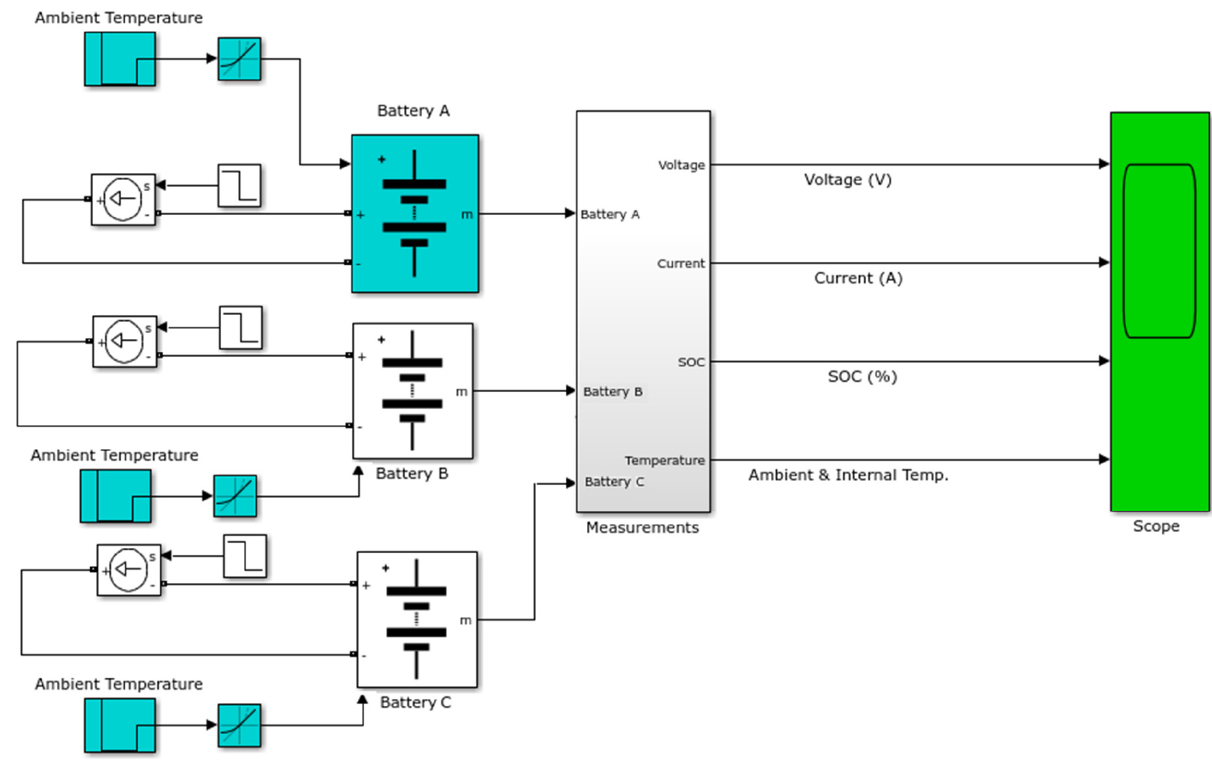
Figure 6. Electric Vehicle Battery Model in Simulink/MATLAB.